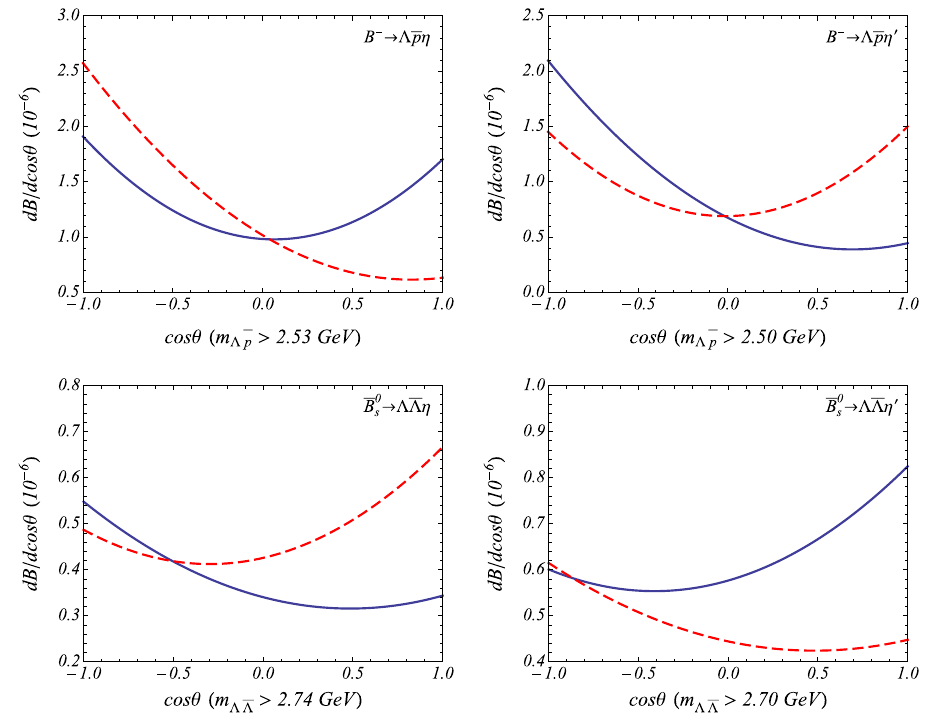
Fig. 5 Angular distributions of B → B ¯ B (cid:3) η ( (cid:3) ) versus cos θ with θ being the angle between the baryon and meson moving directions, where the solid (dash) curves correspond to the constructive (destructive) interference